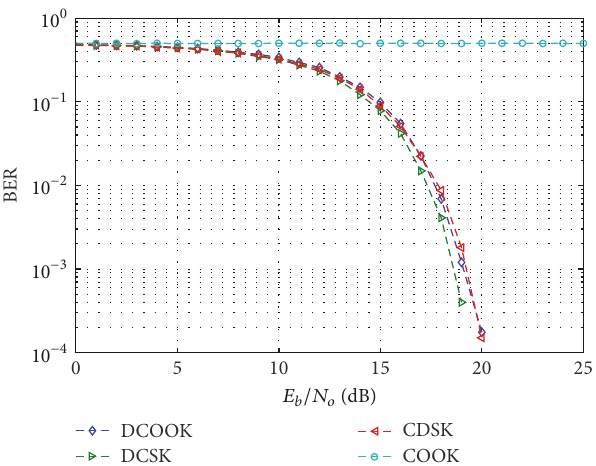
Figure 14: BER performance of DCOOK scheme versus COOK, DCSK, and CDSK schemes at 𝑀 = 500 .